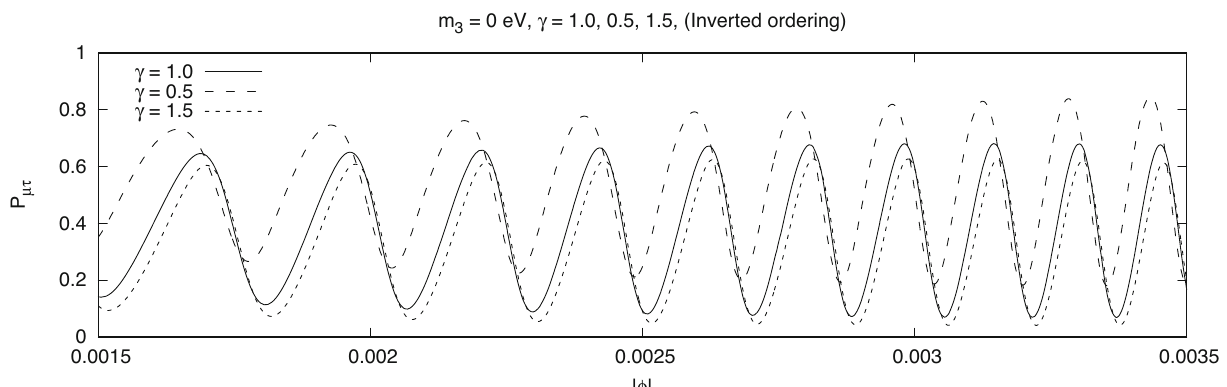
of ν μ → ν τ conversion for γ = 1 . 0 (solid line), γ = 0 . 5 (dashed line), γ = 1 . 5 (dotted line). We take r D = 10 8 km, r S = 10 5 r D , M ADM = 1 M (cid:15) and E 0 = 10 MeV. Neutrino mass squared differences, mixing angles and the Dirac CP phase are taken from the latest global fit